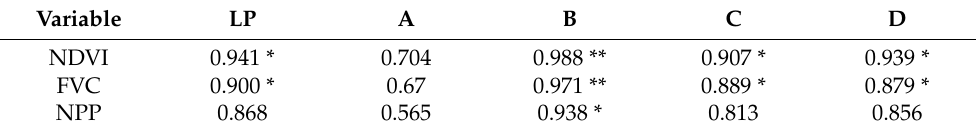
Table 5. Pearson correlation coefficient between RSEI and vegetation index for the Loess Plateau.